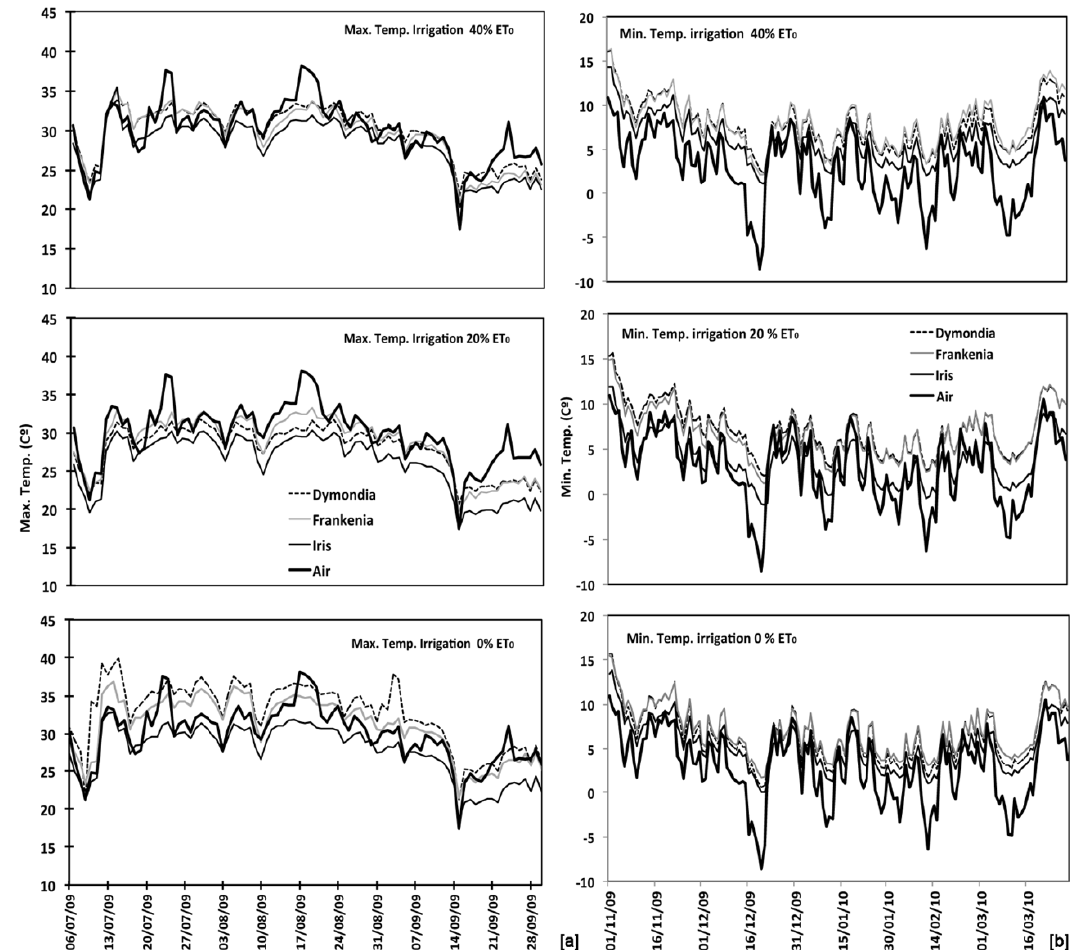
Figure 4. Temperature soil recorded for each species and irrigation treatments (0–20–40% ET 0 ) in relation to air temperature: ( a ) maximum temperatures since July to September; ( b ) minimum temperatures since November to March.